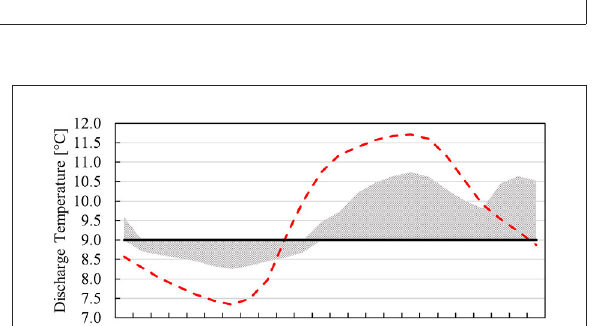
FIGURE6 Calibrated process toolbox simulation built for ML prediction model validation.